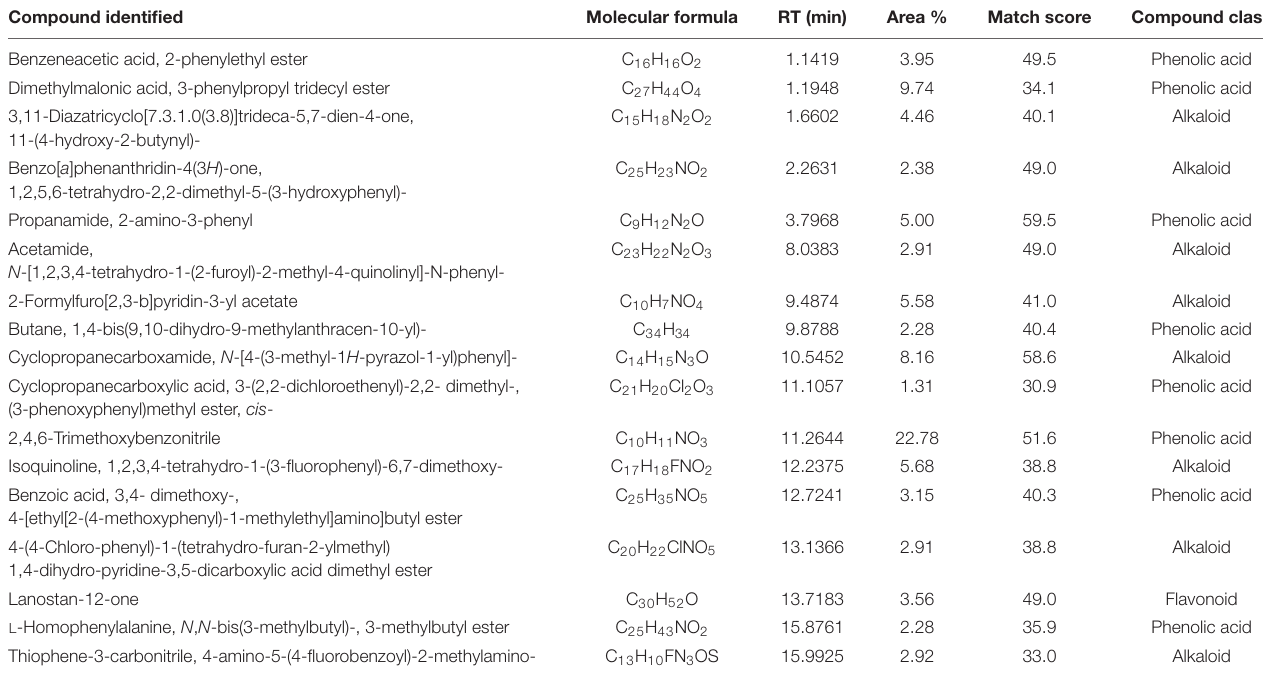
TABLE 4 | Most abundant compounds identified by LC-MS in artemisia